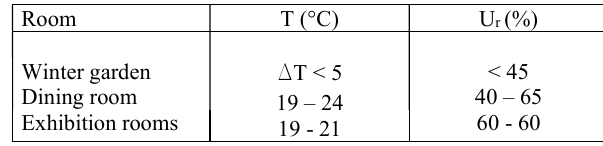
Table 1. Thermo-hygrometric parameters required in relation to the specific room.